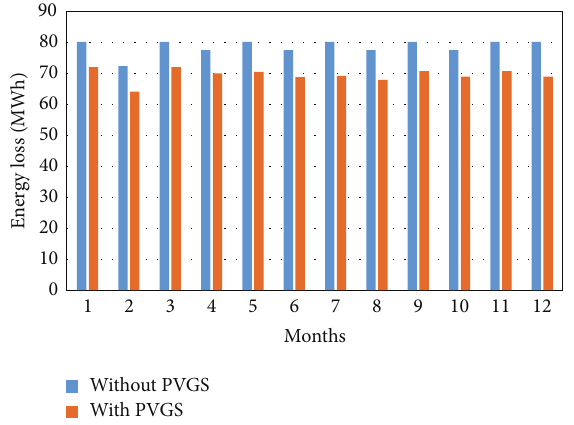
Figure 16: Monthly energy losses with and without PVGS.